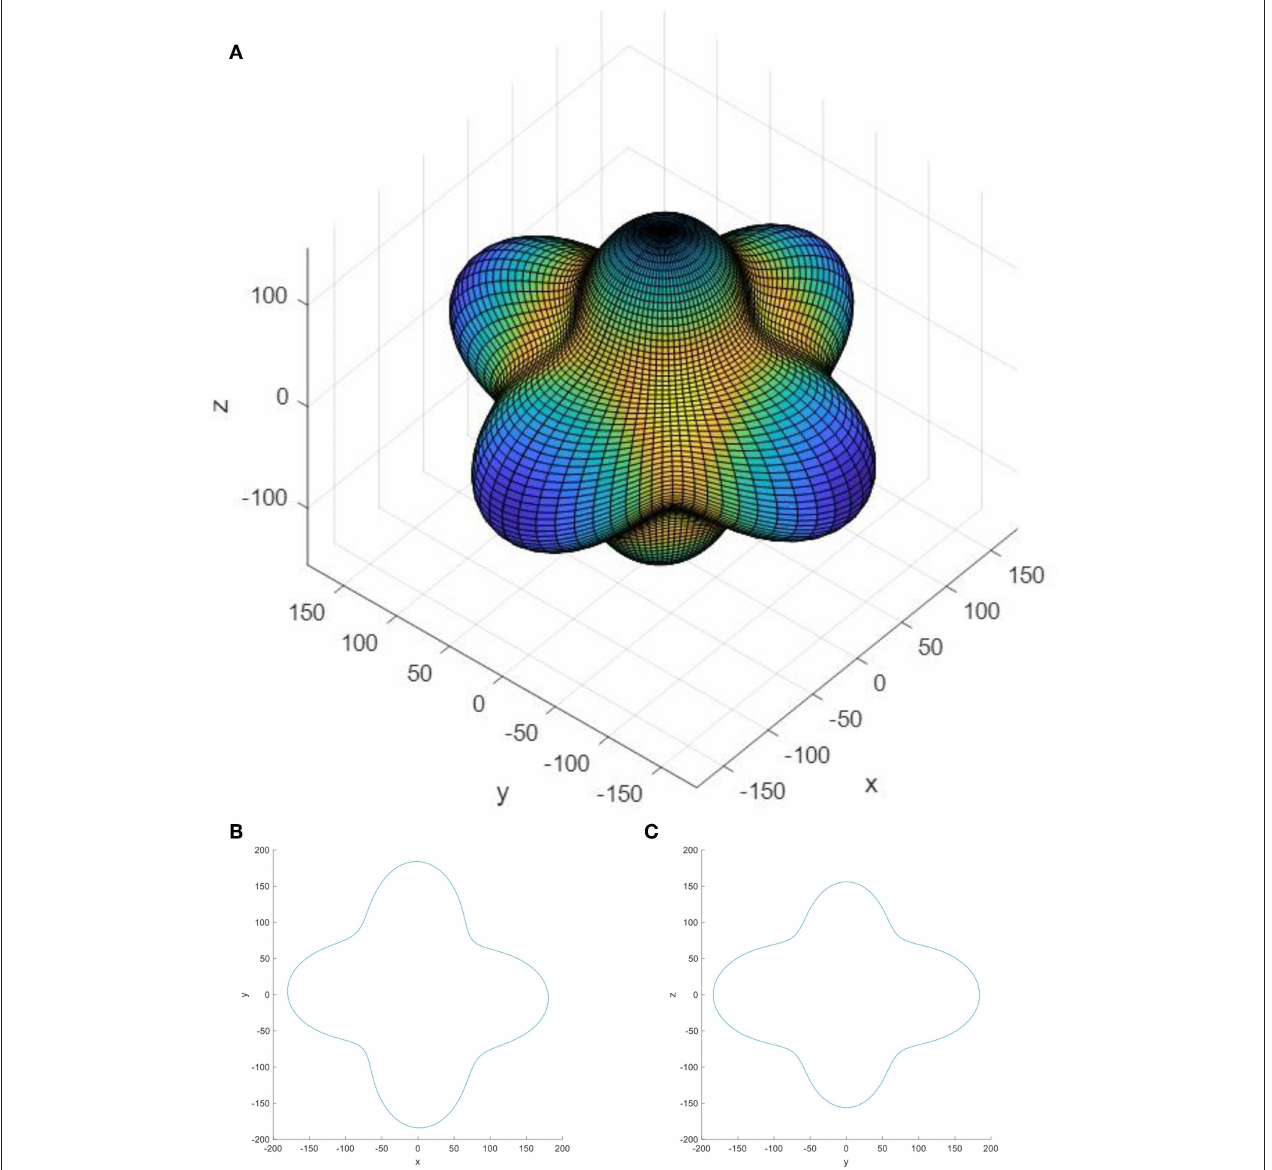
FIGURE 6 | (A) 3D, (B) xy 2D, and (C) yz 2D representation of the elastic modulus of α -DIPAB. The contour indicates the magnitude of elastic modulus along different directions. The units along x and y-axes are GPa.